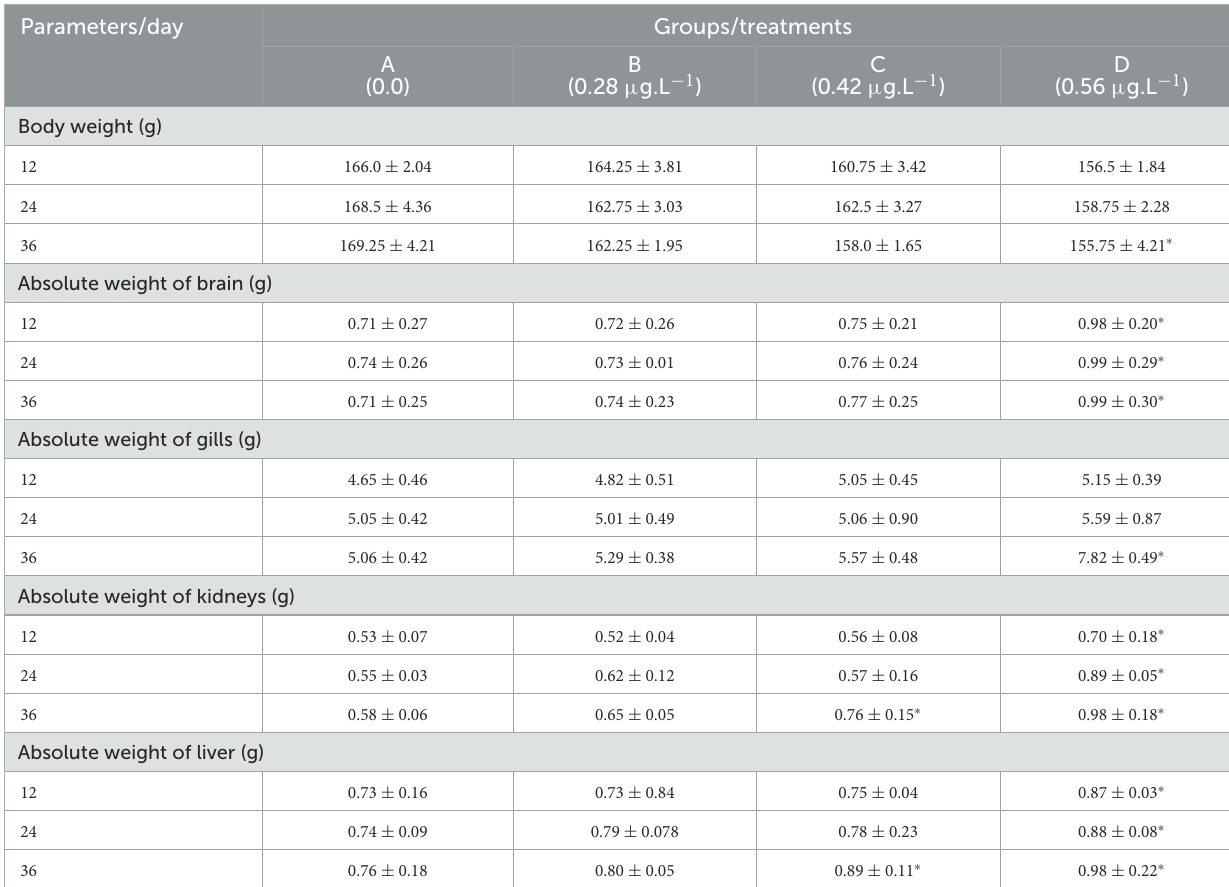
TABLE 2 Body weight and absolute weight of various visceral organs of Labeo rohita treated to copper sulfate with different doses.